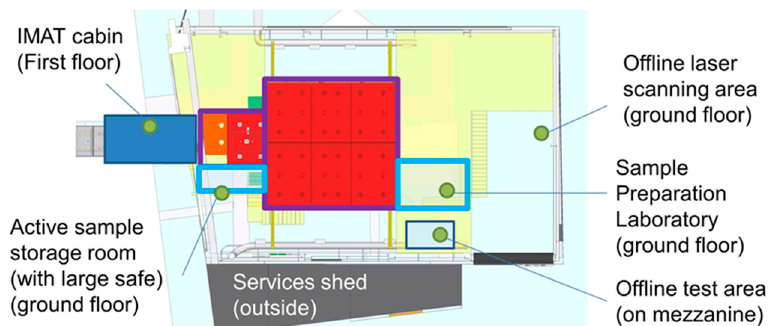
Figure 5. Plan-view sketch of the IMAT extension building, showing the infrastructure around the IMAT blockhouse.